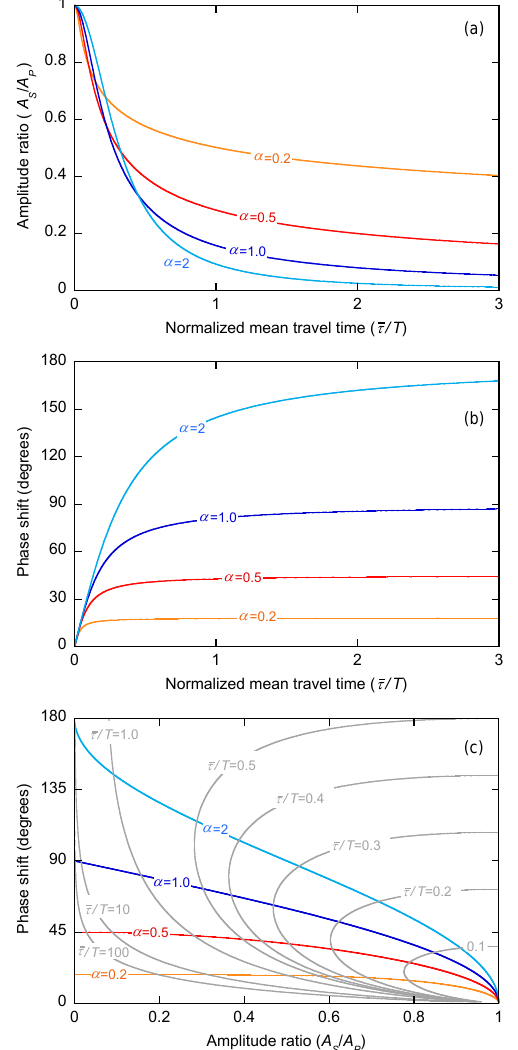
Figure 3. Amplitude ratio and phase shift between seasonal cycles in precipitation and streamflow, for gamma-distributed catchment transit-time distributions with a range of shape factors α (colored lines). (a) Ratio of seasonal cycle amplitudes in streamflow and precipitation ( A S /A P ) as a function of mean transit time ( τ ) nor- malized by the period ( T = 1 /f ) of the tracer cycle. (b) Phase lag between streamflow and precipitation cycles, as a function of mean transit time normalized by the tracer cycle period ( τ/T ) . (c) Rela- tionship between phase lag and amplitude ratio, with contours of shape factor ( α ) ranging from 0.2 to 8 (colored lines), and contours of mean transit time normalized by tracer cycle period τ/T (gray lines). For seasonal tracer cycles, T = 1 /f = 1year and normalized transit time equals time in